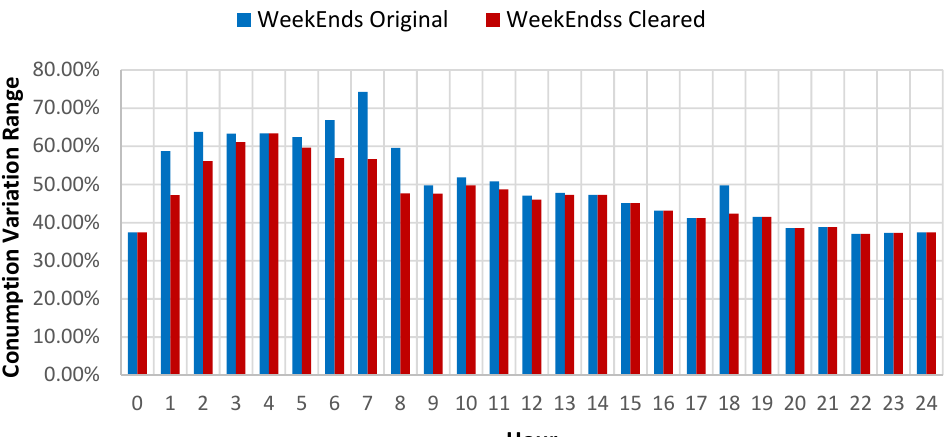
Figure 10. Energy consumption variation range compared to hourly average weekends consumption for original and cleared data sets.